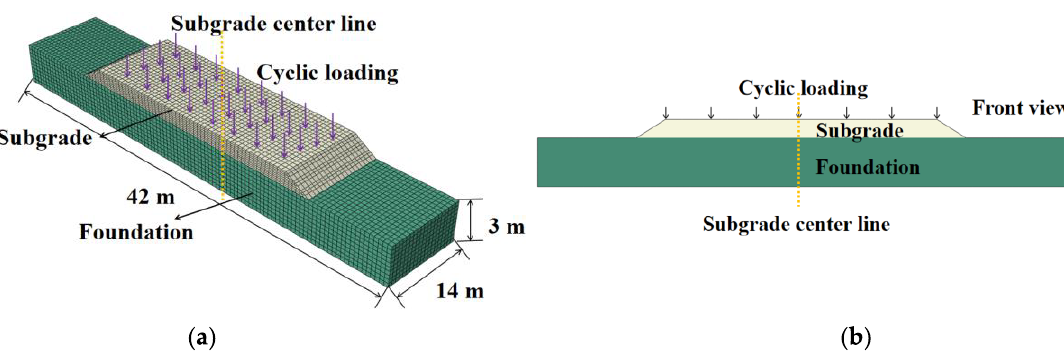
Figure 20. Numerical-calculation model. ( a ) Model mesh; ( b ) Boundary